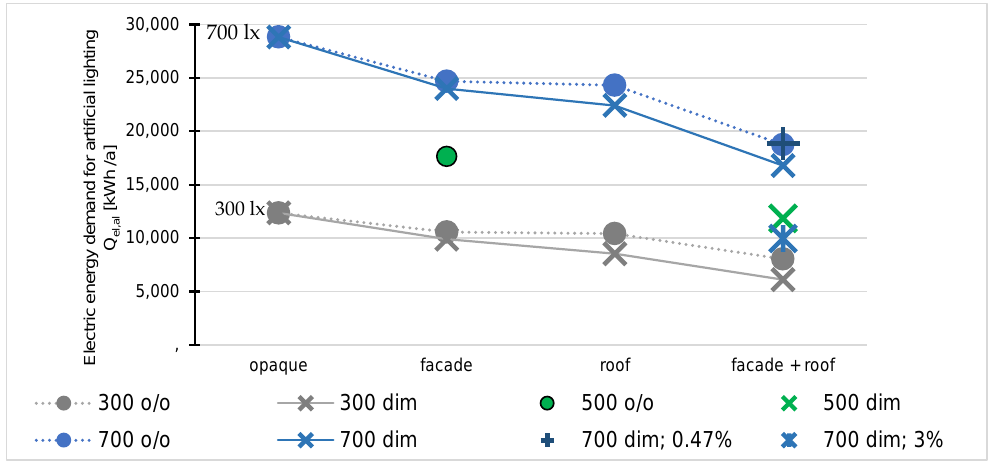
Figure 7. Electrical energy demand for artificial lighting. Table 8. Relative electrical energy savings for AL: The column scenario No. is related to the scenario No. in the rows. The Unit is per cent. Negative values are savings. For detailed scenario No. parameter settings, see Table 6. The header here indicates a short description of the scenario settings. For example, the blue cell in the very bottom of the column with the scenario No. 14 means that variant No. 14 saves 10% electrical energy for AL compared to the case No. 11 indicated at the very left of the row. For another example, going in that row from the blue cell to the left until column with No. 4 on the top means that No. 4 compared to No. 11 saves 57%. Grey cells are relations of a scenario with itself and hence contain a 0 representing no